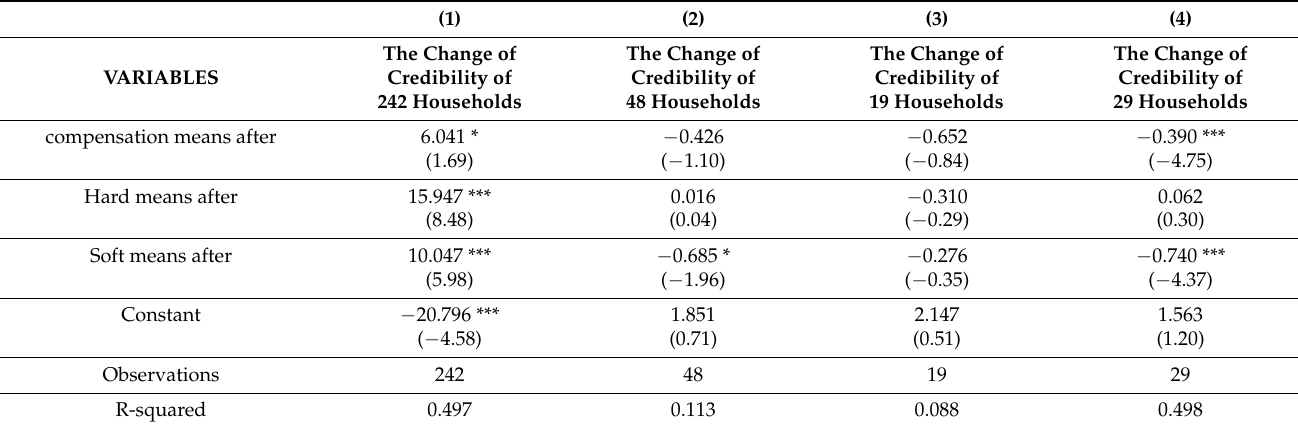
Table 9. Regression results of credibility and administrative